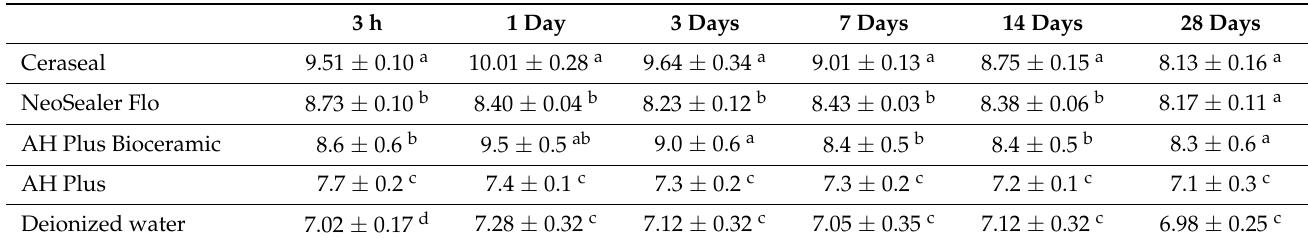
Table 4. Alkalizing activity (mean ± SD; n = 8) of tested materials. The pH of soaking water was measured after immersion of set sealers (+100% of final setting time). Different superscript letters (vertical row) indicate statistically significant differences ( p < 0.05) among sealers.